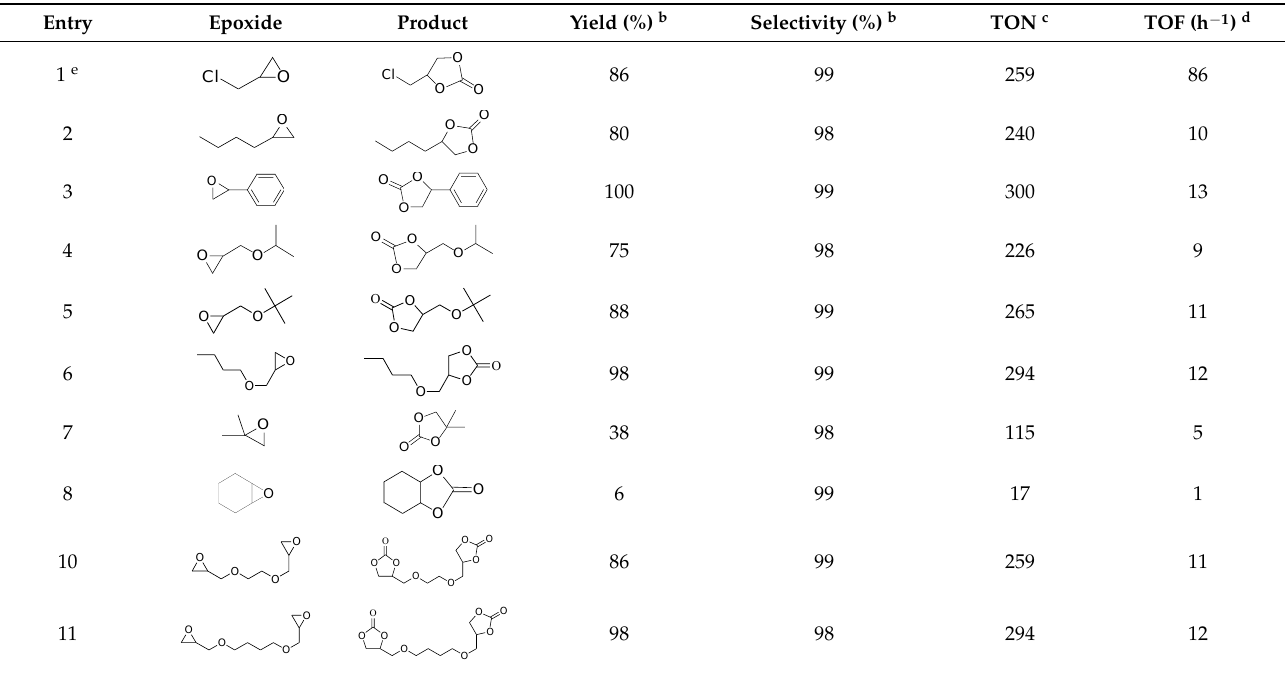
Table 2. Cycloaddition between CO 2 and various epoxides catalyzed by Im-CD1-I a